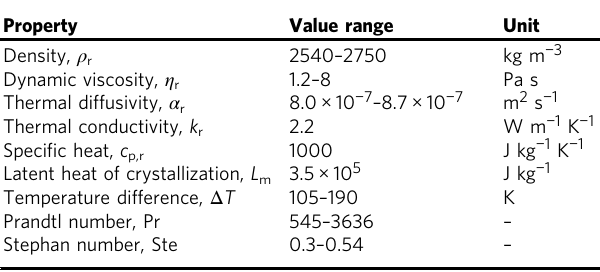
Table 1 Initial thermophysical properties of the